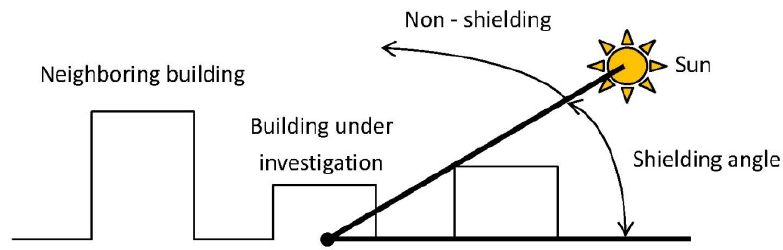
Figure A6. Schematic view of determination of building and neighboring